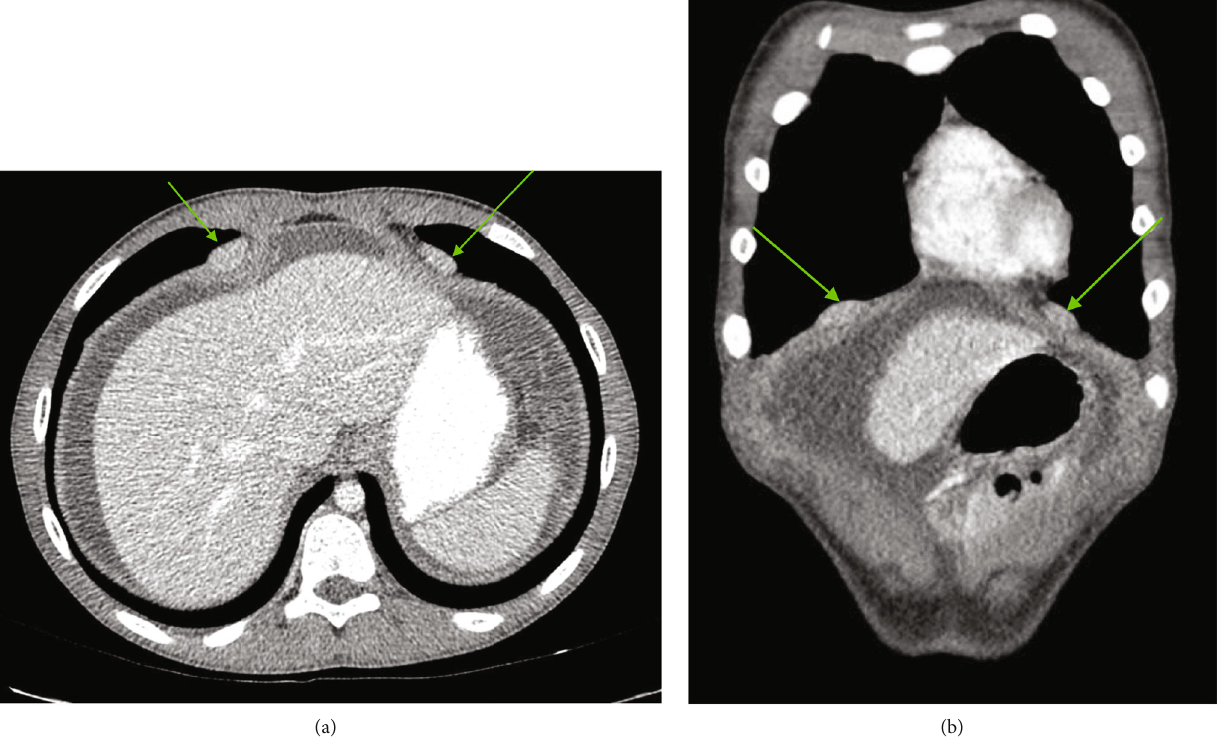
Figure 4: (a) Axial CT with intravenous contrast of the chest demonstrating pleural-based nodules. (b) Coronal CT with intravenous contrast of the chest demonstrating pleural